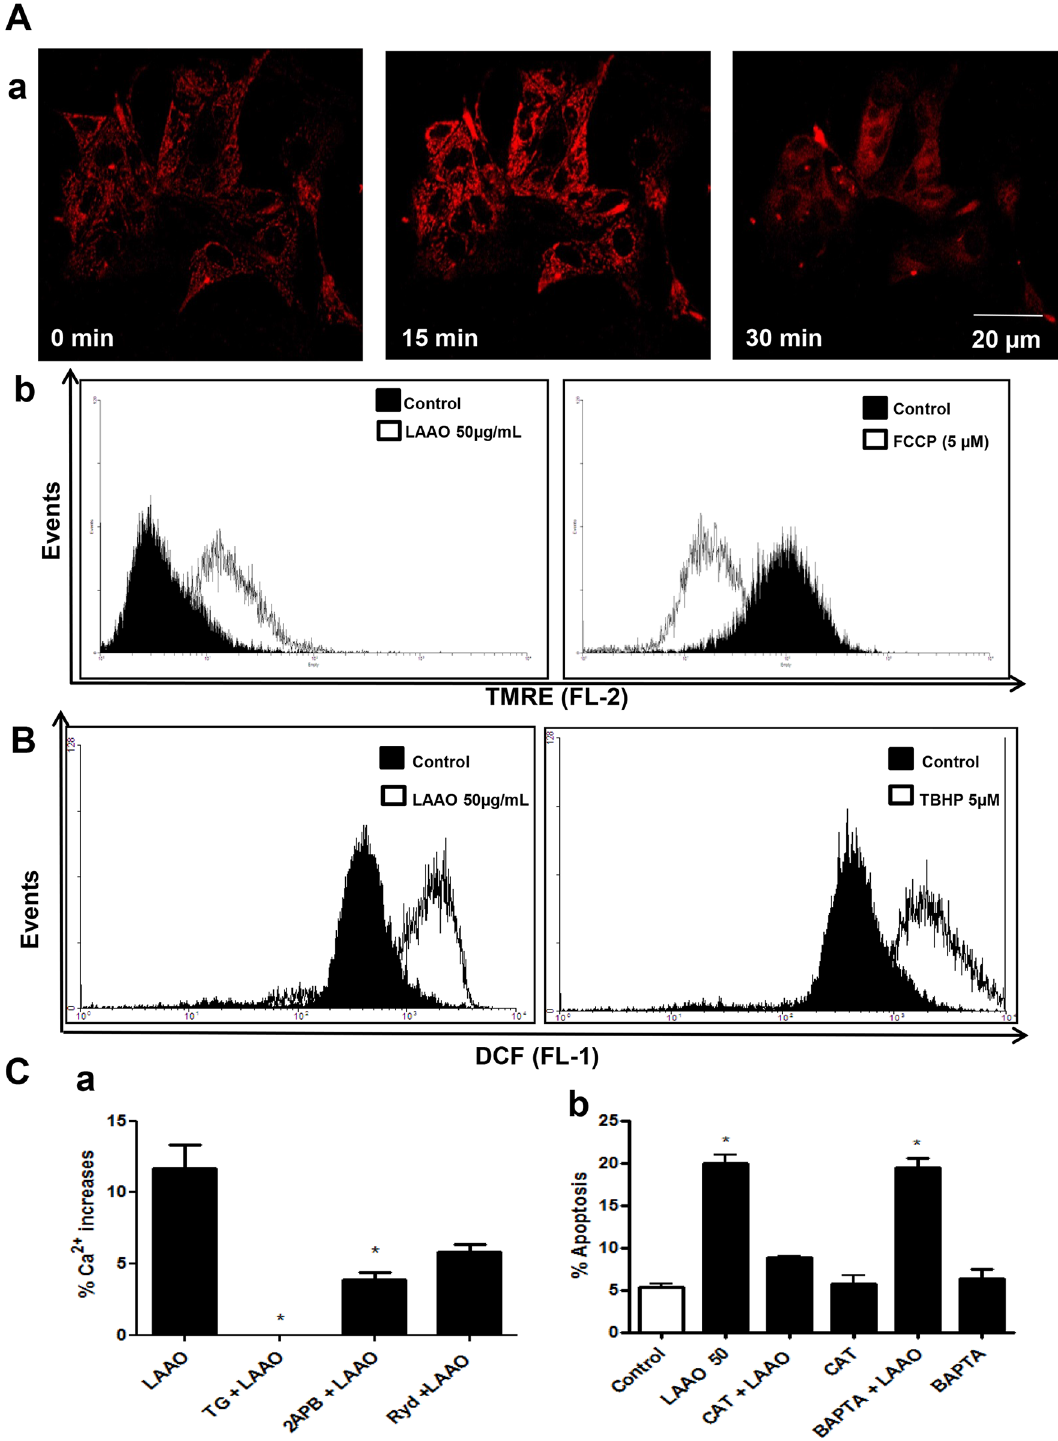
Fig 2. LAAO- Bl exposure induces mitochondrial hyperpolarization, intracellular Ca 2+ mobilization and ROS generation in MDCK cells. (A) Changes on ΔΨ m after LAAO- Bl (50 μ g/mL) stimulation were measured by TMRE fluorescence (25 nM, 15 min at 37°C) and detected by confocal microscopy or flow cytometry. (a) Confocal images from cells TMRE loaded were collected at baseline and seconds after exposure with LAAO- Bl showing the increase of ΔΨ m in MDCK cells in relation to basal levels. (b) Representative histograms obtained from MDCK cells TMRE loaded and exposed with LAAO- Bl (50 μ g/mL). The